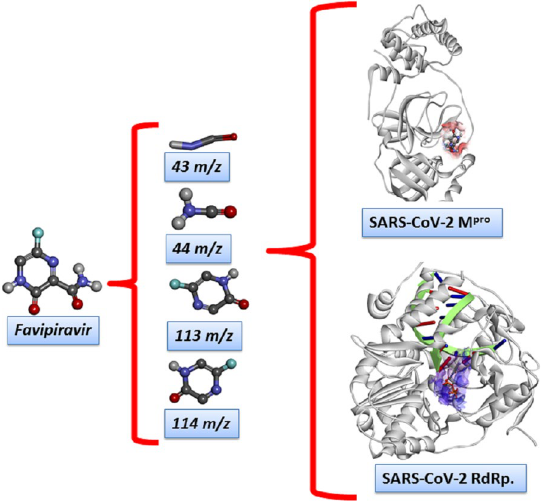
Figure 1. Schematic representation of computational strategy proposed in this study to the investigation of the metabolism effect in drug design. The strategy used to build these models have based on three different situations: ( a ) no previous metabolism and ( b ) prior effect of metabolism to the inhibitory process. Image generated in the Discovery Studio Software 4.5: https:// disco ver. 3ds. com/ disco very- studio- visua lizer- downl